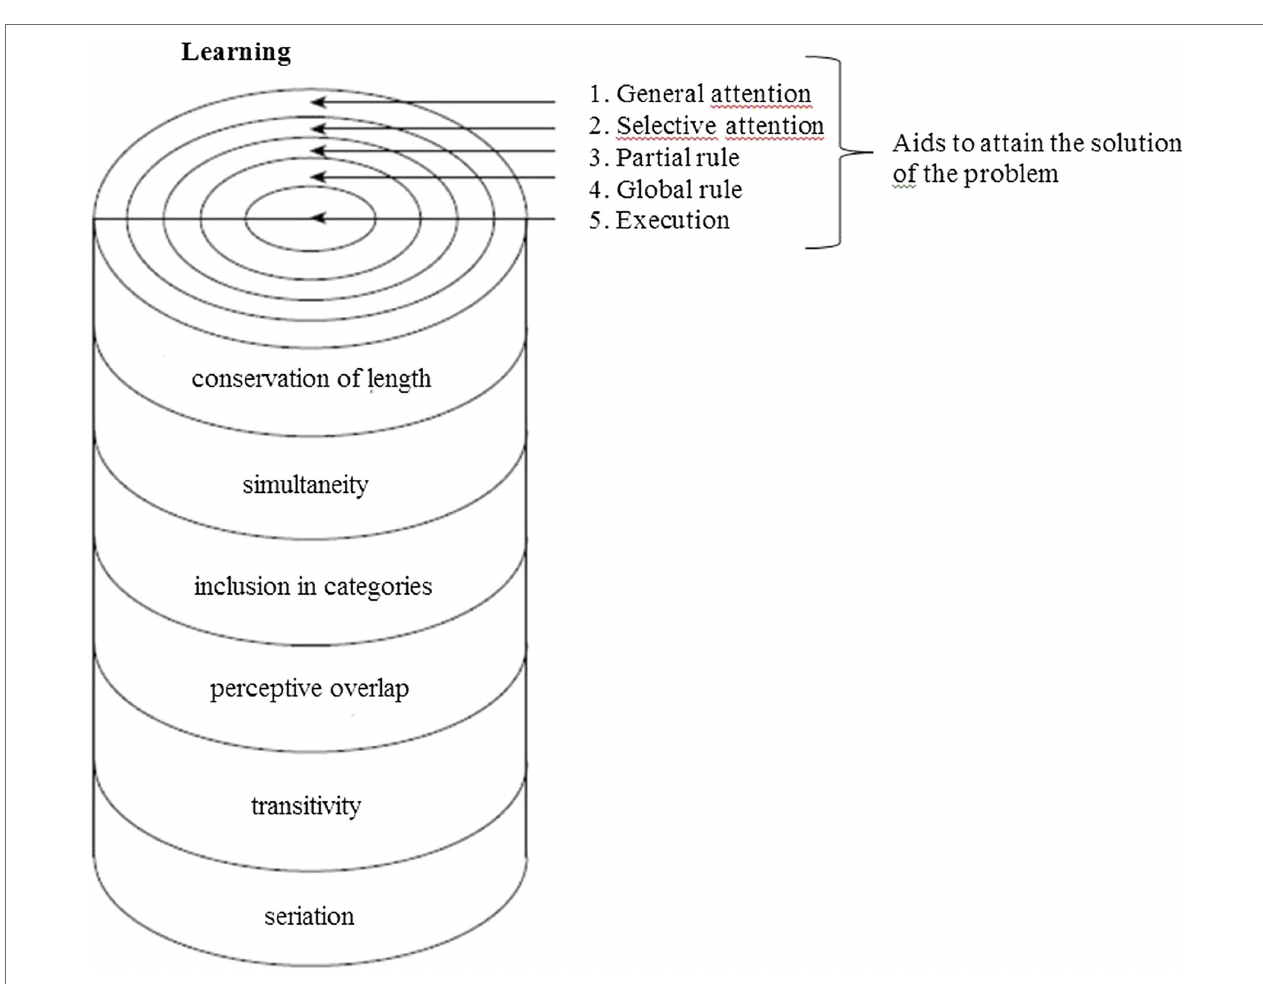
FIGURE 1 | Learning